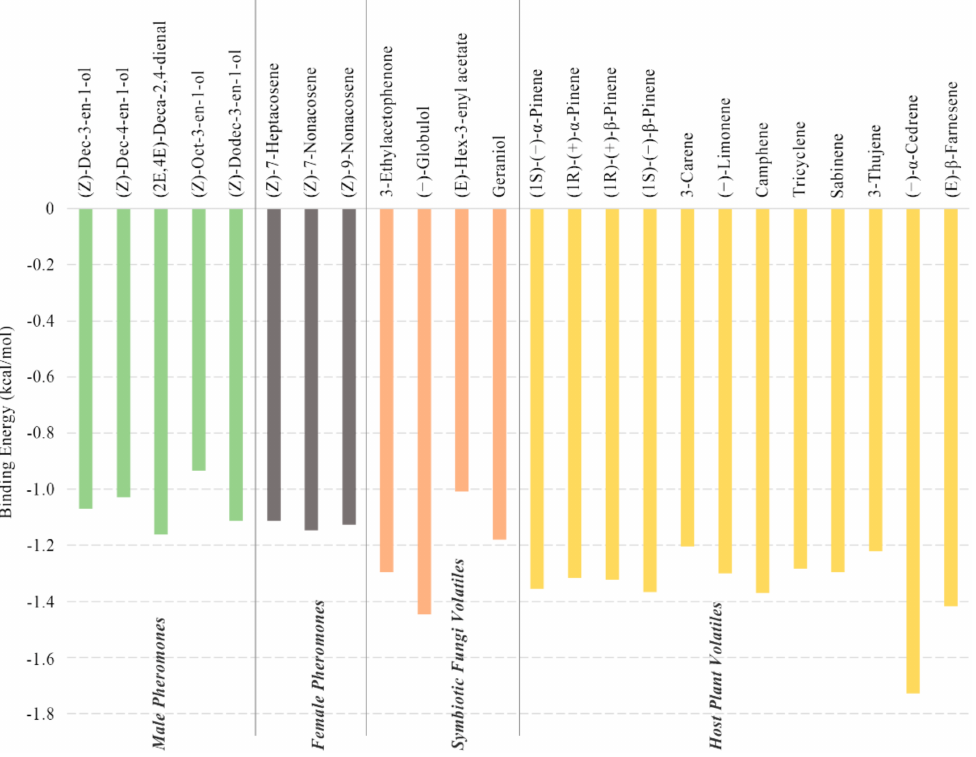
Figure 2. Binding energy of 24 ligands docked to the SnocOBP12